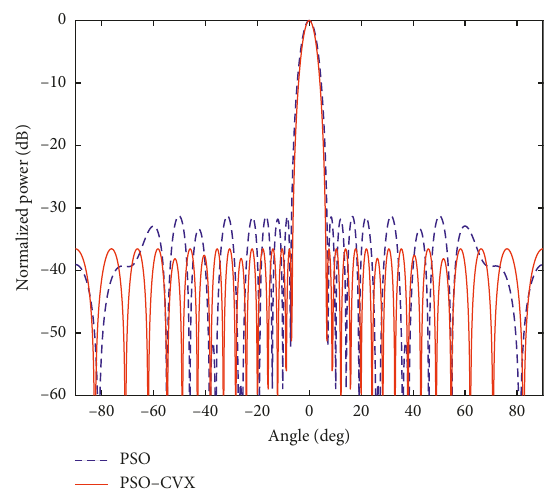
Figure 6: Contrast between the PSO-CVX and PSO